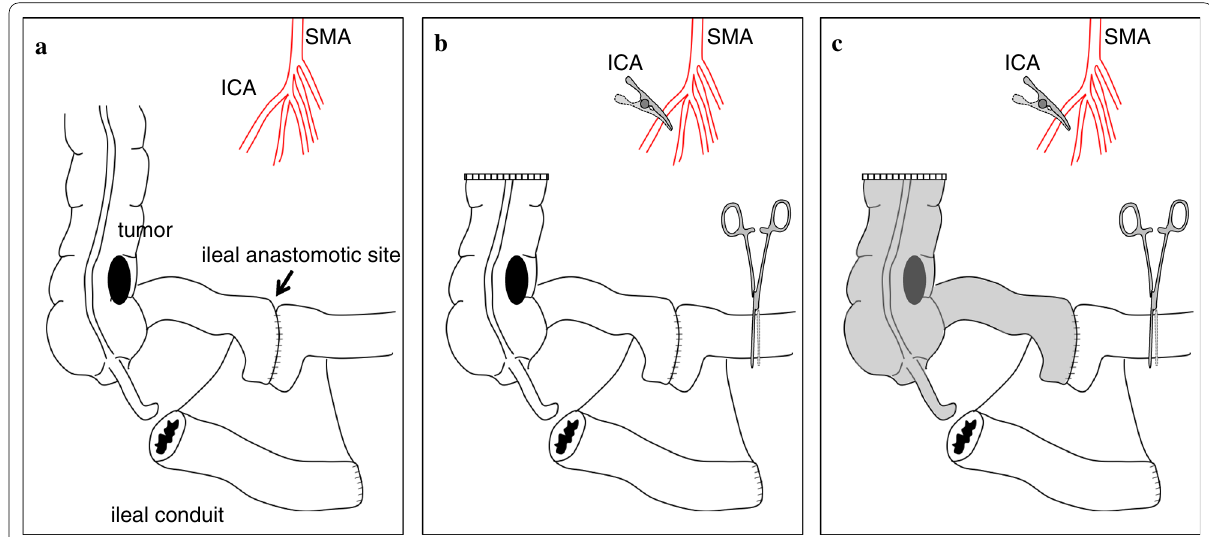
Fig. 2 Operative schema showing relationship of the tumor, ileal anastomotic site, ileal conduit and ileocecal artery (ICA) with the superior mesenteric artery (SMA) ( a – c ). The ascending colon was transected, and the ICA at its root and marginal artery at oral side of ileal anastomotic site were clamped ( b ). After intravenous injection of ICG, fluorescence is clearly visible in the ischemic area (Gray color) ( c